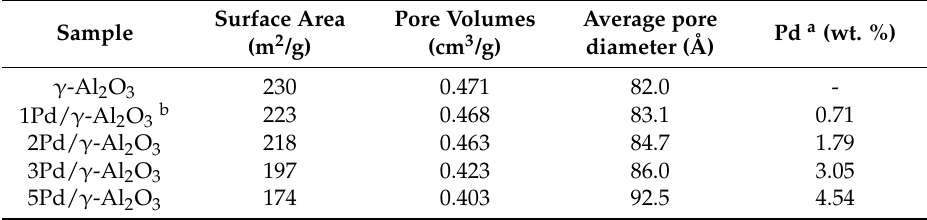
Table 1. BET and ICP-AES analyses of the